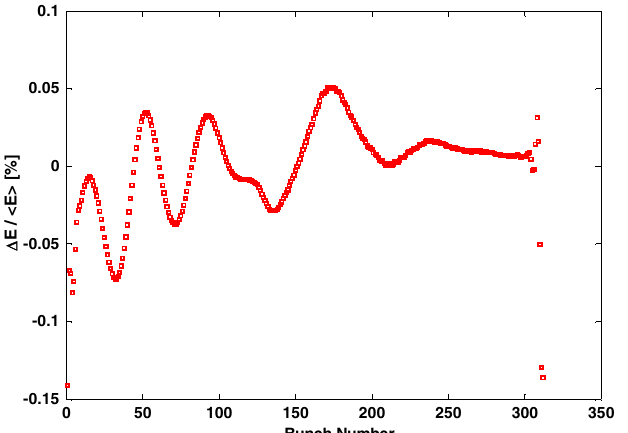
FIG. 19. Dependence of the rms energy spread on the rise time for the analytical model (blue) and for the equivalent T T time for the model presented in this paper. filling